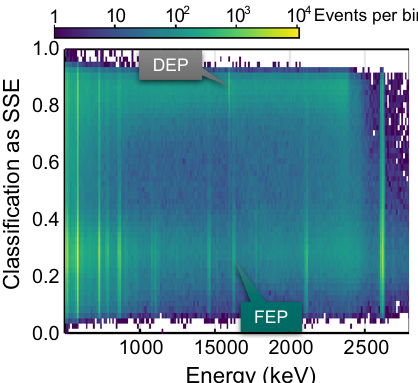
Fig. 6 Distributionoftheoutput, c ,ofthecombinedencoder+classifier network for the test dataset (bin size X: 10 keV, Y: 0.02). The autoen- coder is trained on events above 1000 keV and the classifier on events from the DEP (mostly SS) and FEP (mostly MS). The DEP events clus- teraround0.9whilethepeakscontainingmostlyMSeventsarecentered at about